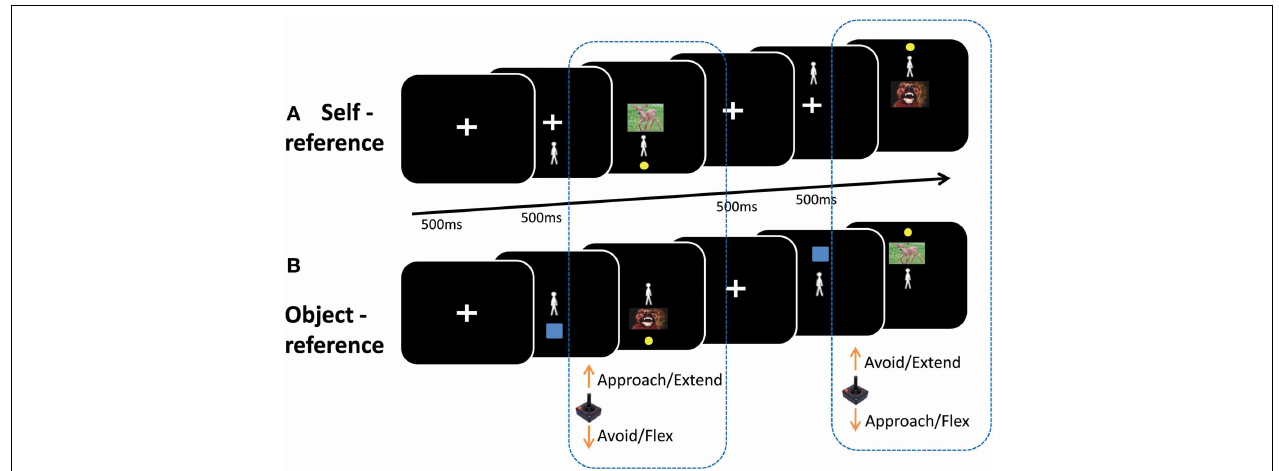
FIGURE 1 | Illustration of the task. (A) Self-reference condition: a manikin was presented either above or below an emotional picture. Participants moved the manikin toward or away from the picture depending on the block. In congruent blocks (approach-positive, avoid-negative) participants were instructed to move the manikin with a joystick toward positive pictures and away from negative pictures, as fast as possible upon picture presentation. In incongruent blocks (approach-negative, avoid-positive) participants had to move toward negative and away from positive pictures. (B) Object-reference